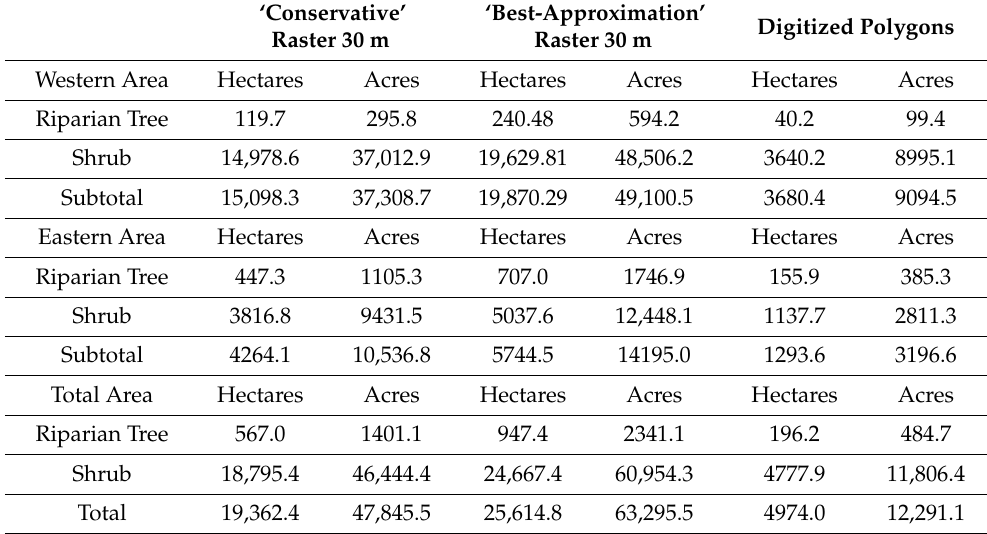
Table 2. Riparian area estimates divided into the West (top), East (middle) and Total (merged) (bottom) using three methods for totaling the riparian vegetation land cover area.